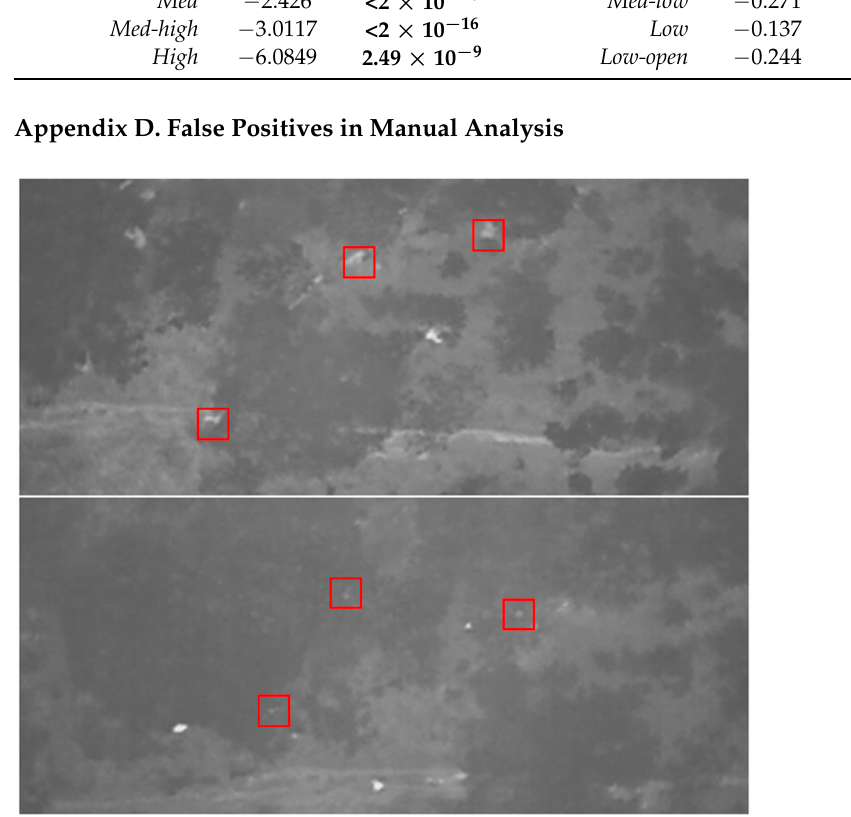
Figure A2. Thermal images showing the false positives caused by hot ground (top) and hot rocks (bottom). The red squares indicate the false positives.